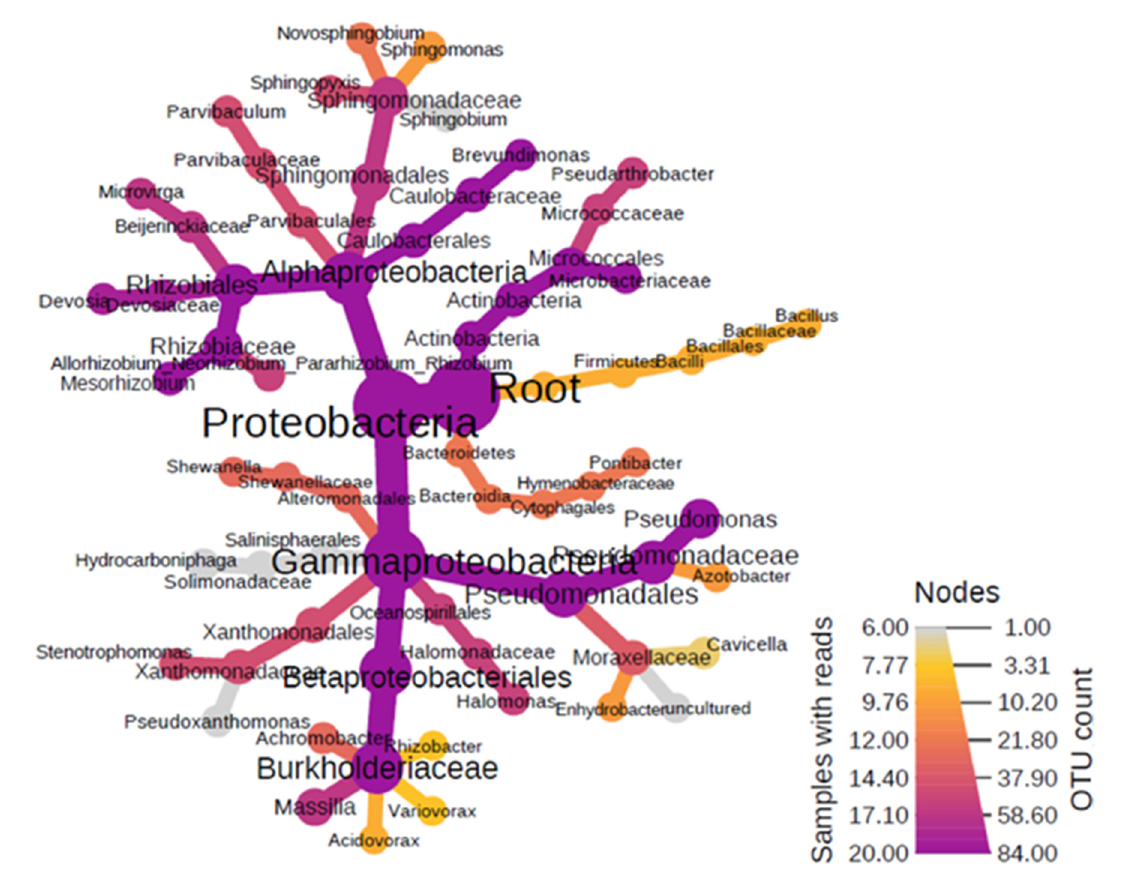
Figure 2. Heat diagram showing dominant bacterial assemblages within the organic aerosol fractions.